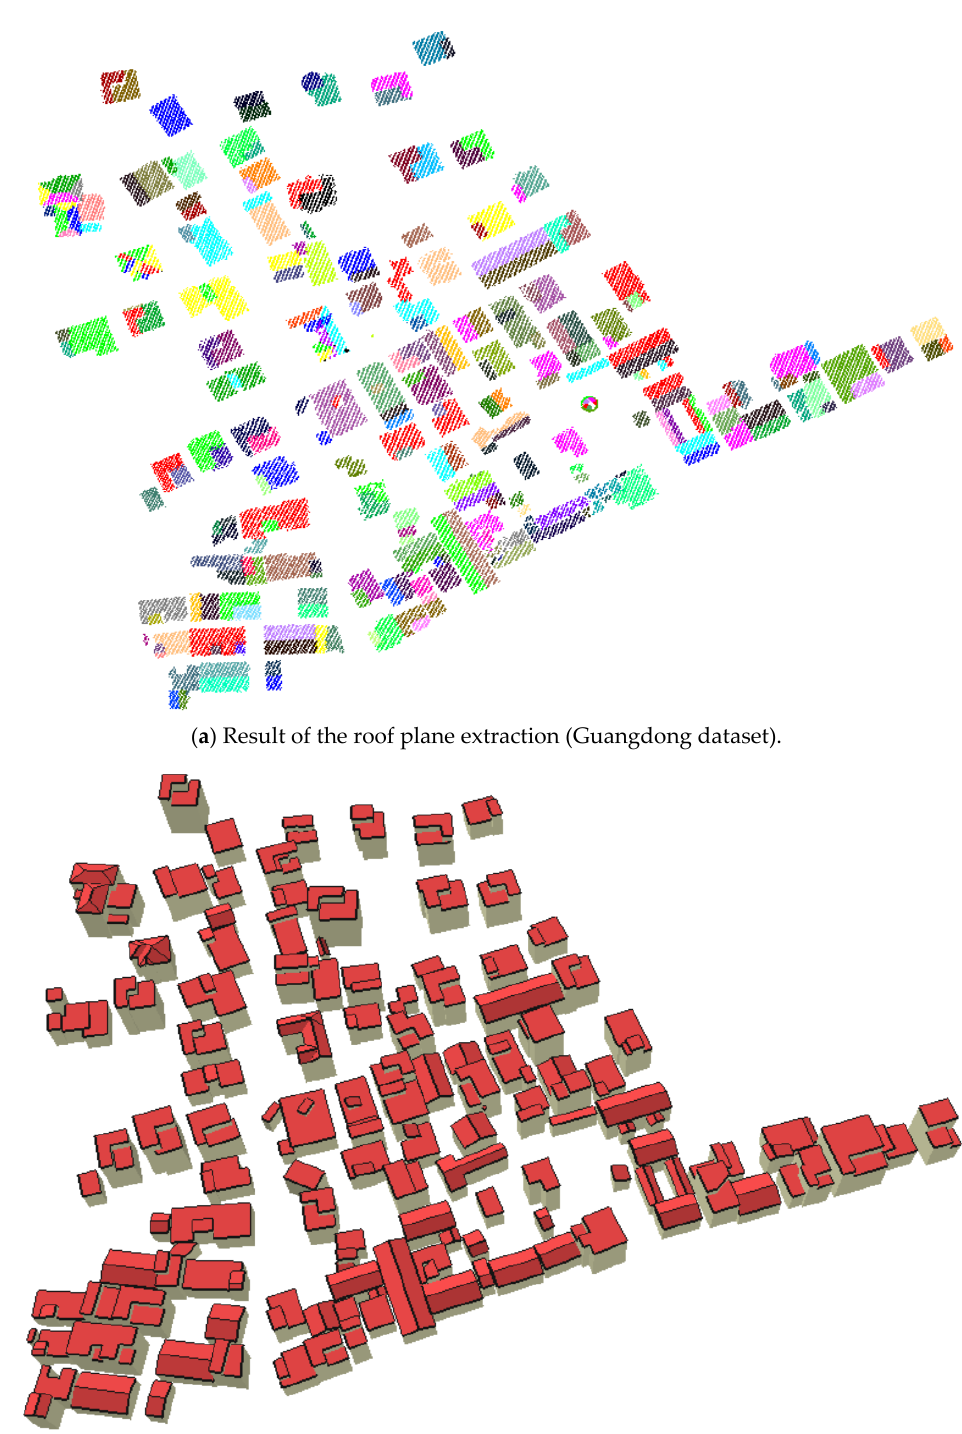
Figure 13. Results of roof plane segmentation and 3D reconstruction from the Guangdong dataset.